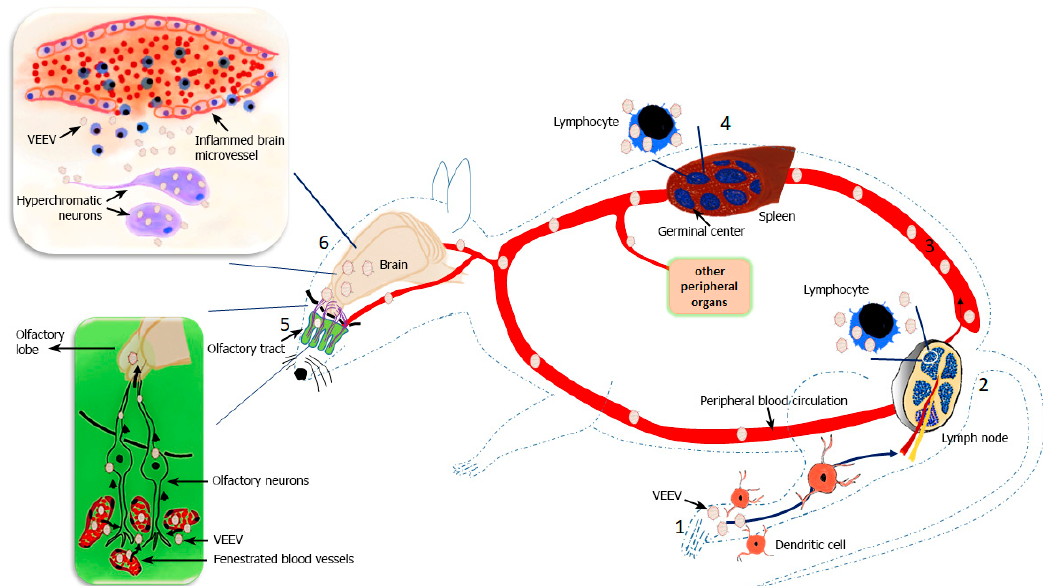
Figure 2. Biphasic replication of VEEV in mice. Mice infected via VEEV footpad injection mimics the natural mode of transmission by mosquito bites (1). After initial inoculation, regional dendritic cells take up the virus and transport it to the local draining lymph nodes, where VEEV replicates in lymphocytes (2) and is then released into the circulation resulting in viremia (3). VEEV replicates in various tissues, but lymphoid organs such as the spleen are primary replication sites (4). Around 24–36 h post infection, VEEV escapes into the olfactory tract infecting olfactory nerve endings initiating the first step of CNS phase of infection (5). Virus moves through the axons of the olfactory neurons and enters the olfactory lobe of the brain (large insert). In the brain, VEEV primarily infects the neurons, but glia and oligodendrocytes are also targets of VEEV infection. VEEV induced inflammation causes vascular cuffing and alteration in the BBB allowing mononuclear lymphocytes to enter the brain (6). VEEV mediated alteration of the BBB may allow the virus to enter the brain, but this route of entry is debated. Table 1. Description of mutations in Venezuelan equine encephalitis virus (VEEV) strains and resulting phenotypic changes.